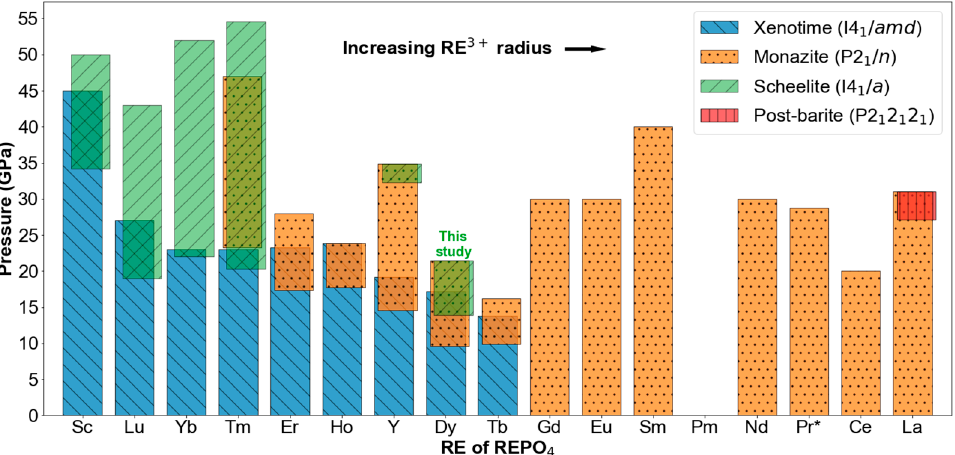
Figure 2. High-pressure phase map of the experimentally observed phases of all single-RE REPO 4 s except PmPO 4 because Pm is both radioactive and extremely rare. The legend lists the phases with their corresponding space groups. For each composition, the upper limit of the highest bar(s) represents the highest pressure at which data are reported and does not represent a phase boundary. See text for references to the sources of phase data. All phase data are compiled from XRD studies except for PrPO 4 , which has only been characterized via Raman spectroscopy * [26].